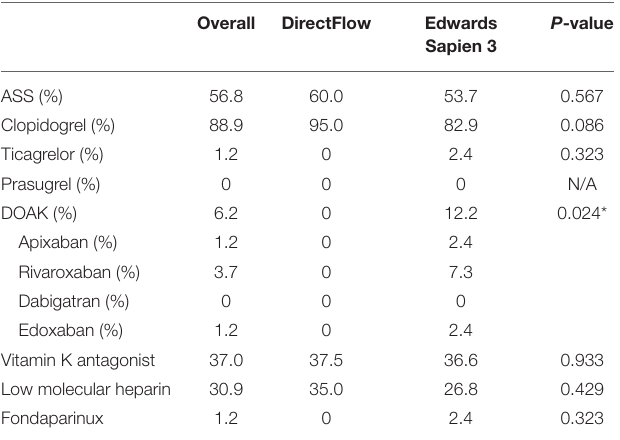
TABLE 4 | Anticoagulants and thrombocyte aggregation inhibitors post TAVI (matched cohort).